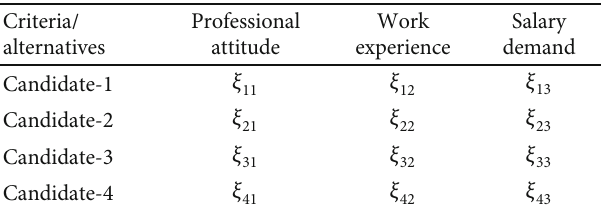
Table 3: Combined decision matrix.